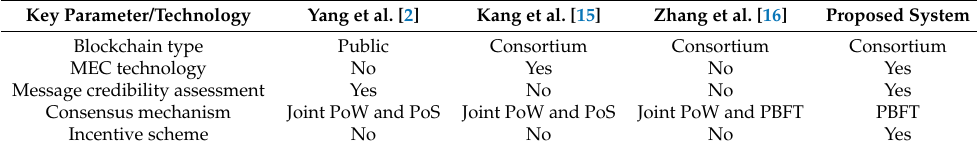
Table 5. The key parameter comparison of our proposed system with other